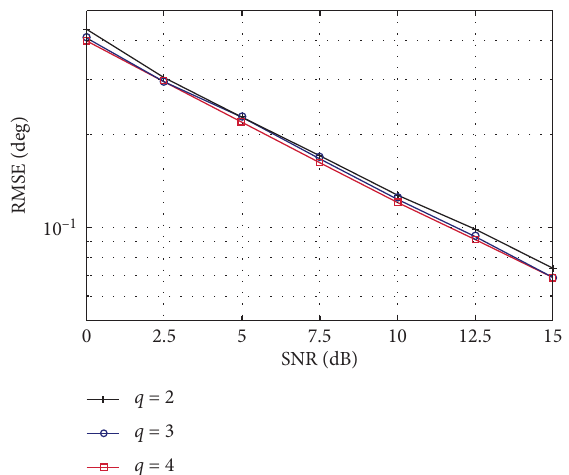
Figure 10: DOA estimation results of the proposed method with � 0 . 1 e j π . c 1